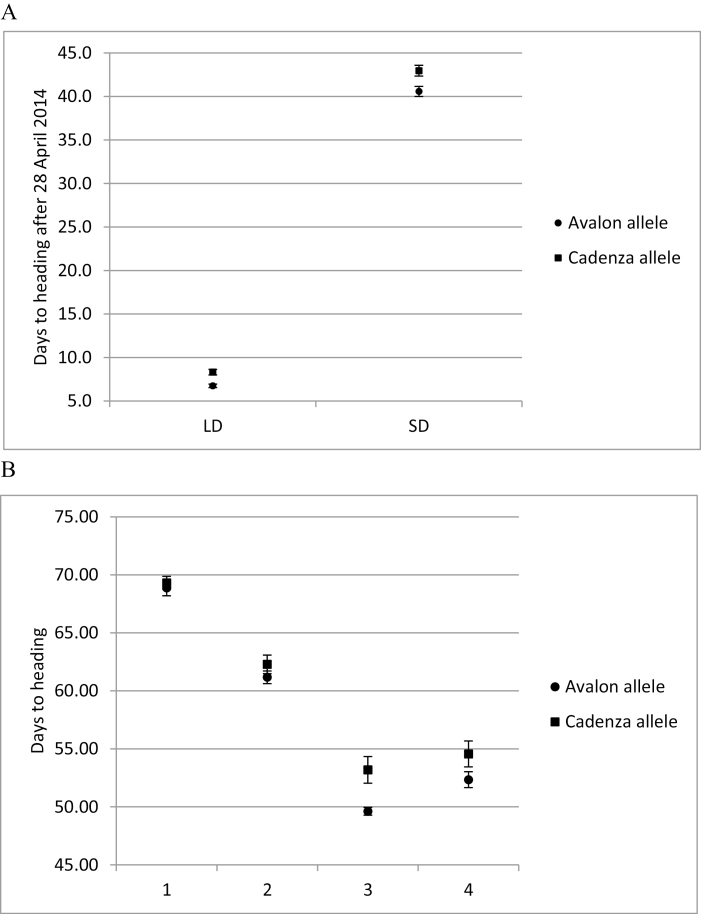
Average days to ear emergence (G55) for leading tillers of controlled-environment-grown Avalon×Cadenza NILs. Filled circles and filled squares represent the NILs carrying the Avalon and Cadenza alleles at 3A, respectively. (A) Short days (SDs) and long days (LDs) correspond to 10 h and 16 h light, respectively. (B) Response to vernalization using selected recombinant lines. Treatments for 0, 4, 6, and 8 weeks. The vertical bars indicate the SD.